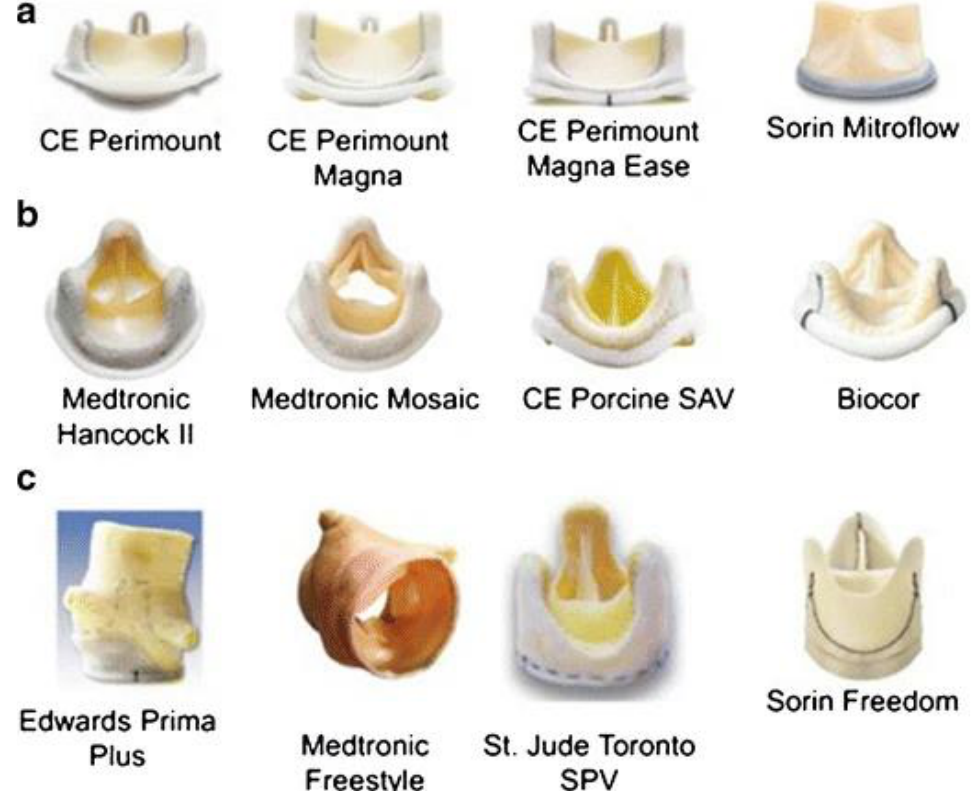
Figure 4. Types of bioprosthetic valves: ( a ) stented pericardial bovine bioprosthetic valves, ( b ) stented porcine aortic valve bioprostheses, ( c ) stentless bioprosthetic valves. Reprinted with permission from ref. [92]. Copyright 2018, Springer Nature.